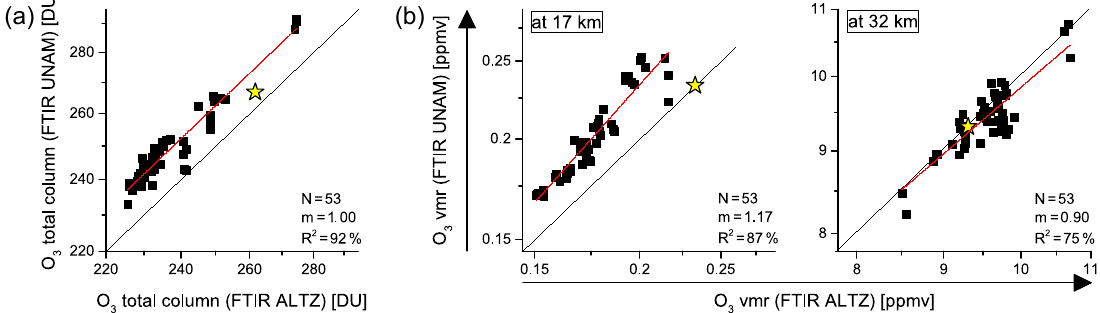
Figure 7. Correlation of O 3 data products obtained from the Altzomoni and UNAM FTIR measurements. The yellow stars represent the a priori values, the black lines are the one-to-one diagonals and the red lines are the fitted linear regression lines. (a) Total column abundances. (b) Volume mixing ratios at 17 and 32kma.s.l. (in the UNAM kernel plot of Fig. 5 the respective kernels are highlighted by red and green colour). Please note that for this comparison the Altzomoni data have been smoothed by the UNAM averaging kernels according to Eq. (7).